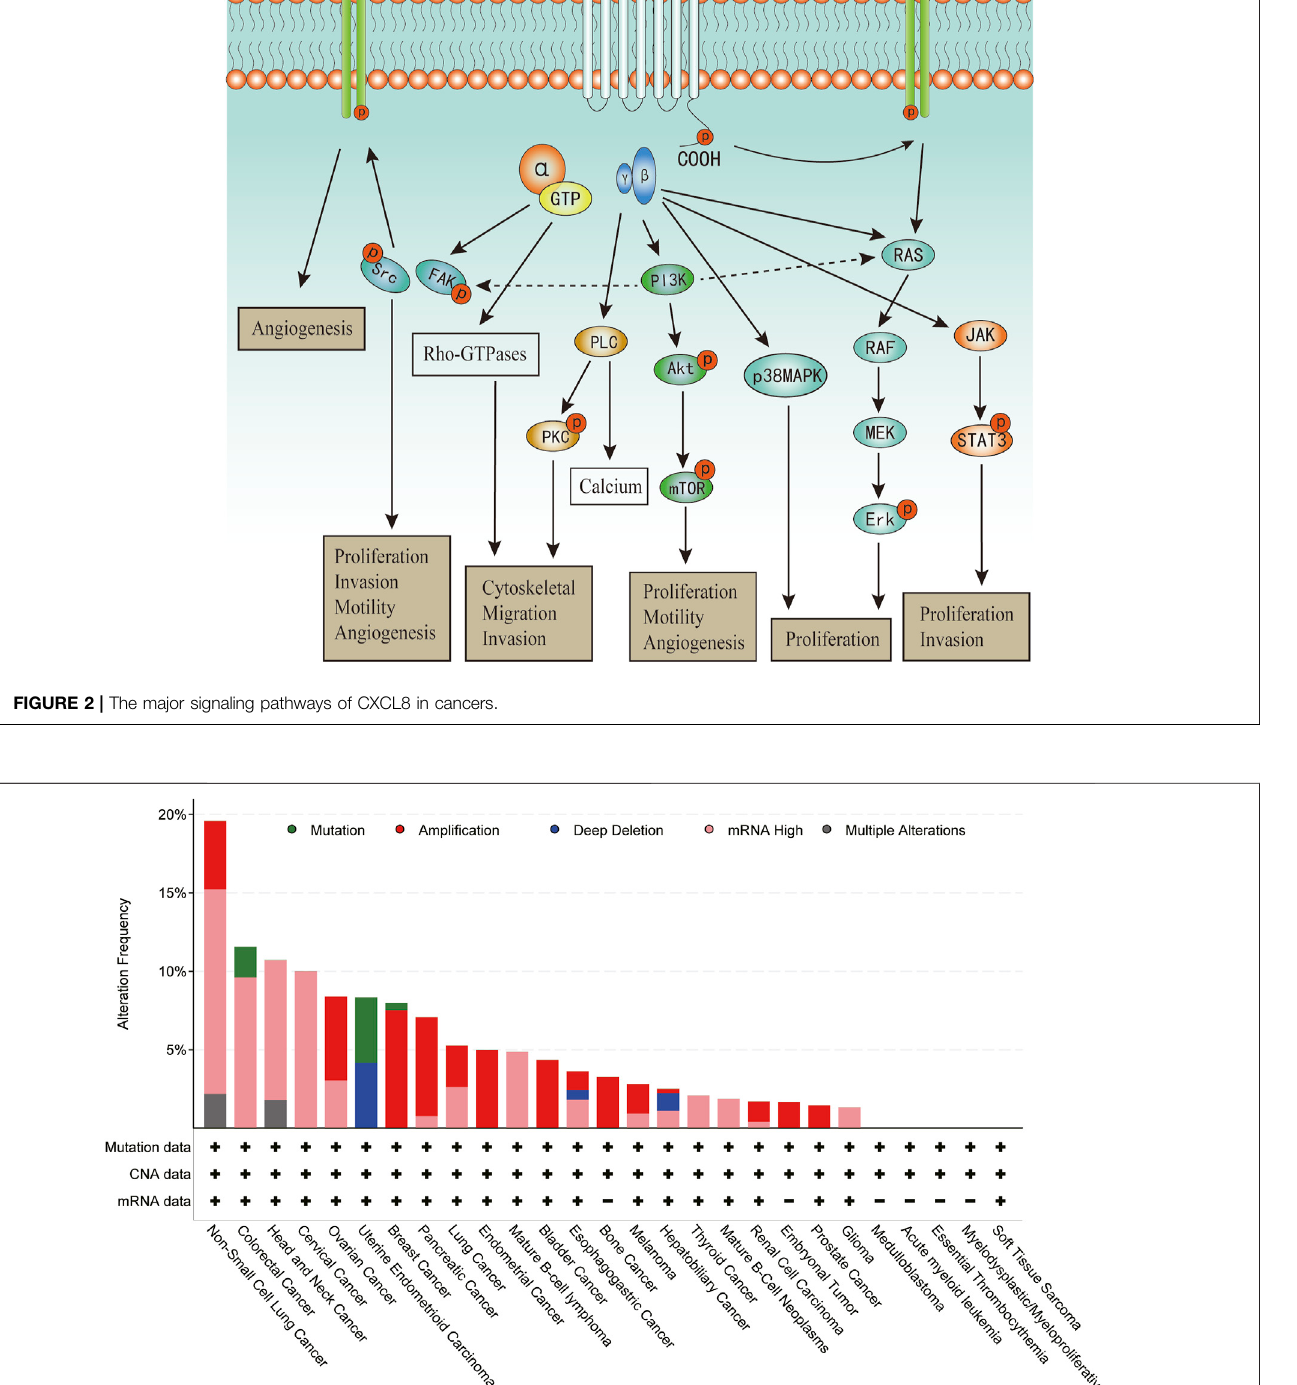
Frontiers in Molecular Biosciences |